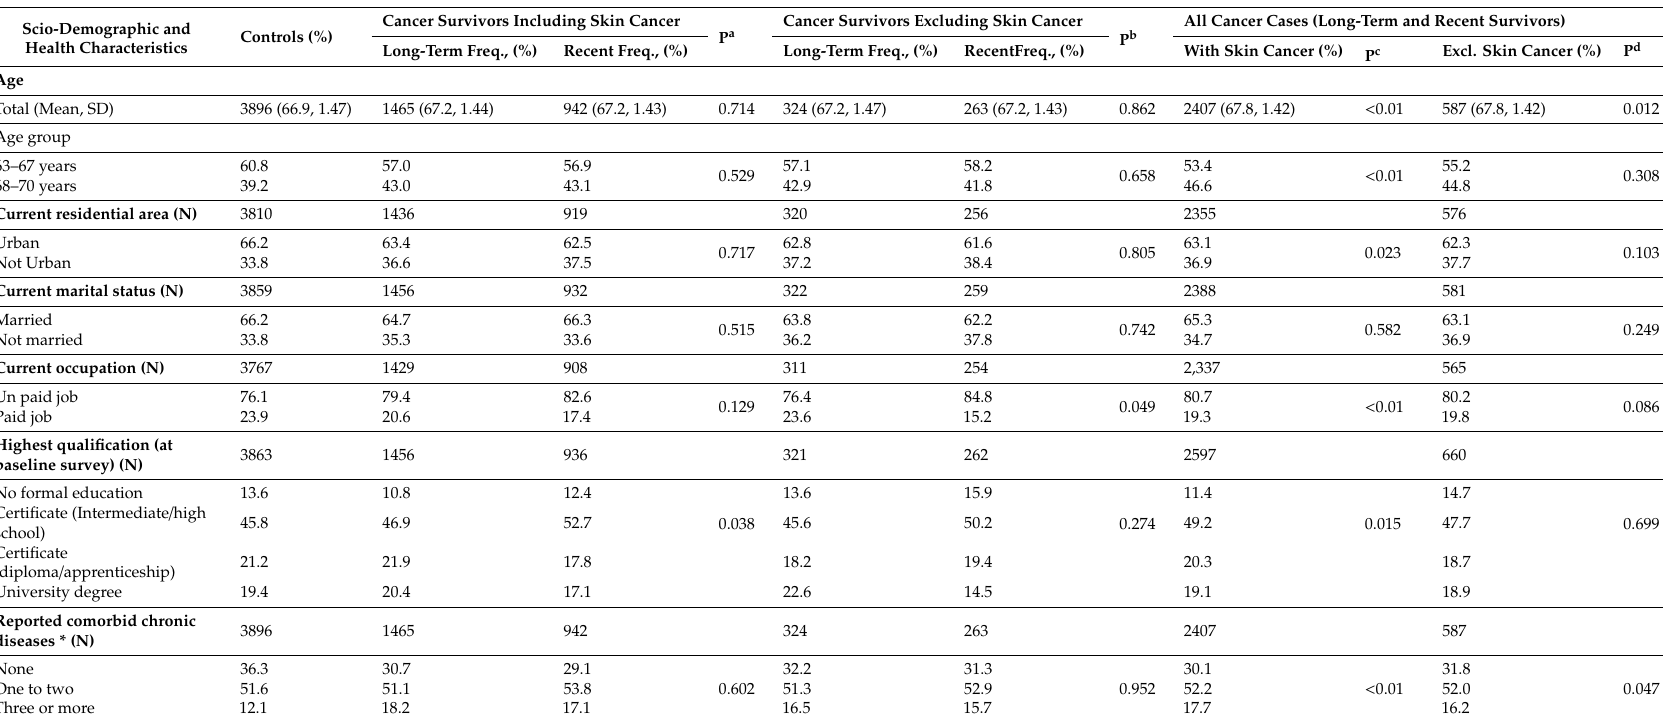
Table 2. Characteristics of cancer survivors (with and without skin cancer) and the control